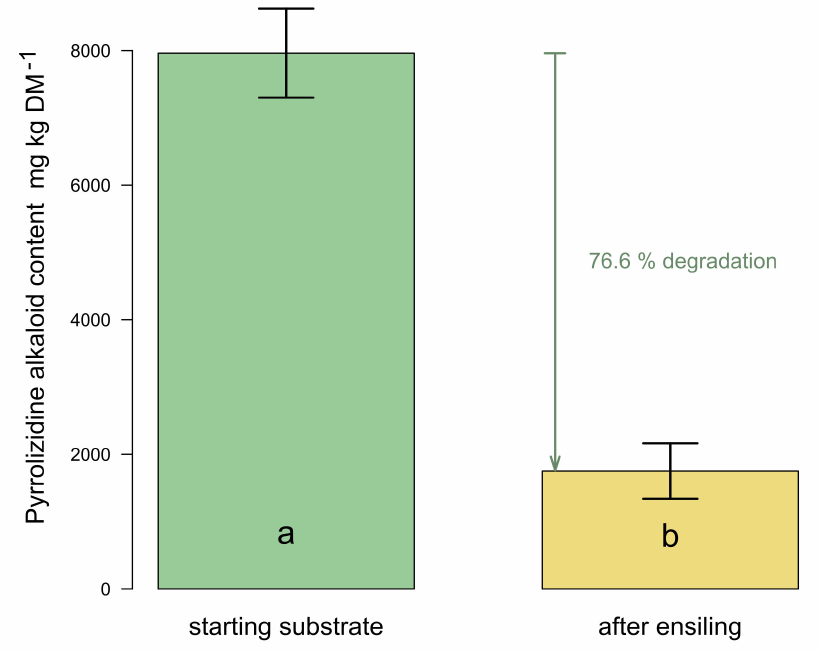
Figure 2. Extent of degradation of the total amount of PAs/PANOs after 92 days of ensiling. Different letters indicate significant differences in PA/PANO content (Dunn-Test, p < 0.001). Error bars represent the standard deviations of the